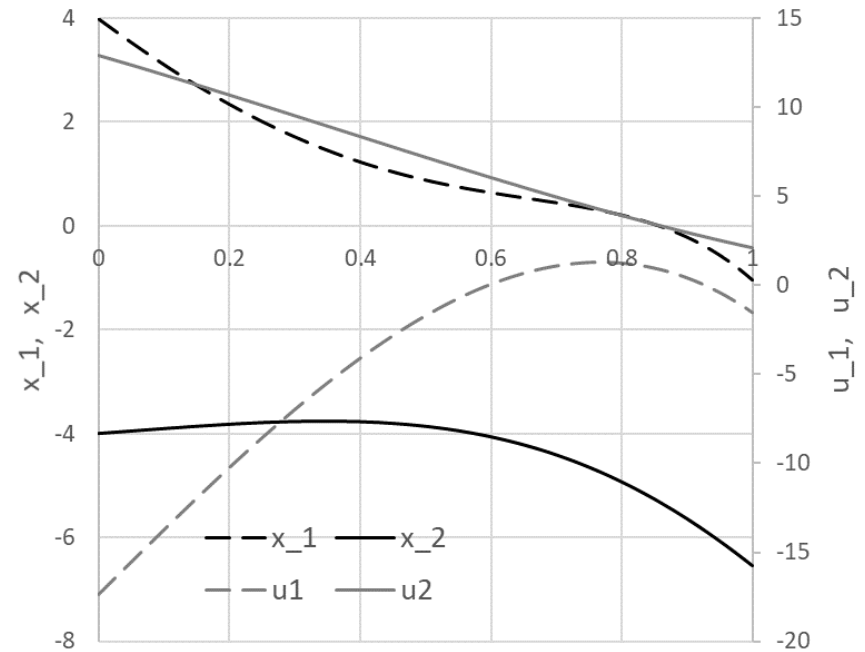
Figure 12. Optimal trajectories computed by the spreadsheet method for problem 3.2.